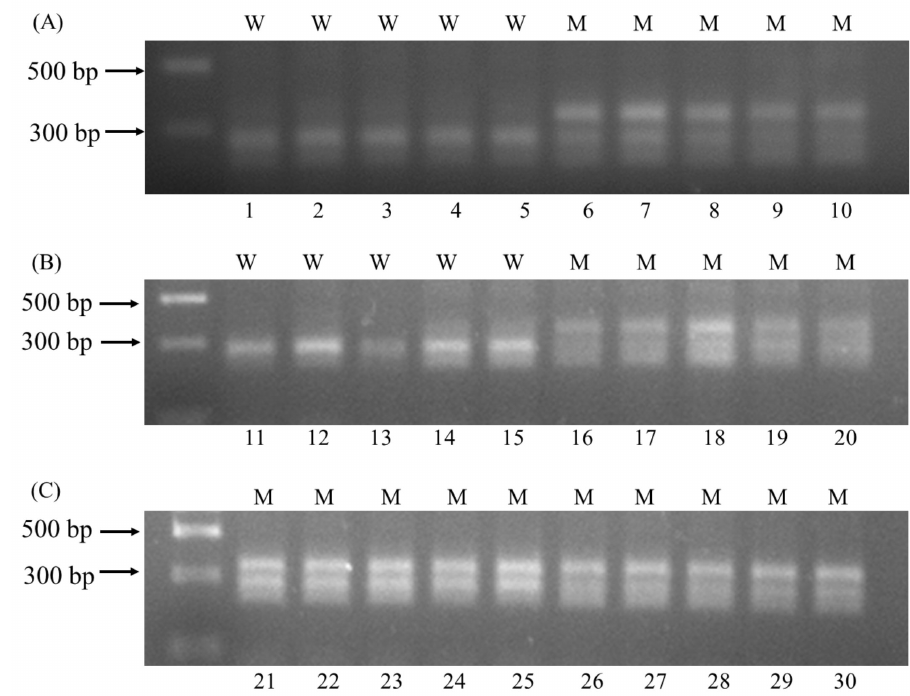
Figure 3. CAPS analysis of 30 A. auriculata plants carrying wild-type ALS alleles (W) or mutant ALS alleles (M). ( A ) Lane 1–5 were samples of YZ-S, lane 6-10 were samples of YZ-2; ( B ) lane 11–15 were samples of YZ-3, lane 16–20 were samples of YZ-4; ( C ) lane 21–25 were samples of YZ-8, lane 26–30 were samples of